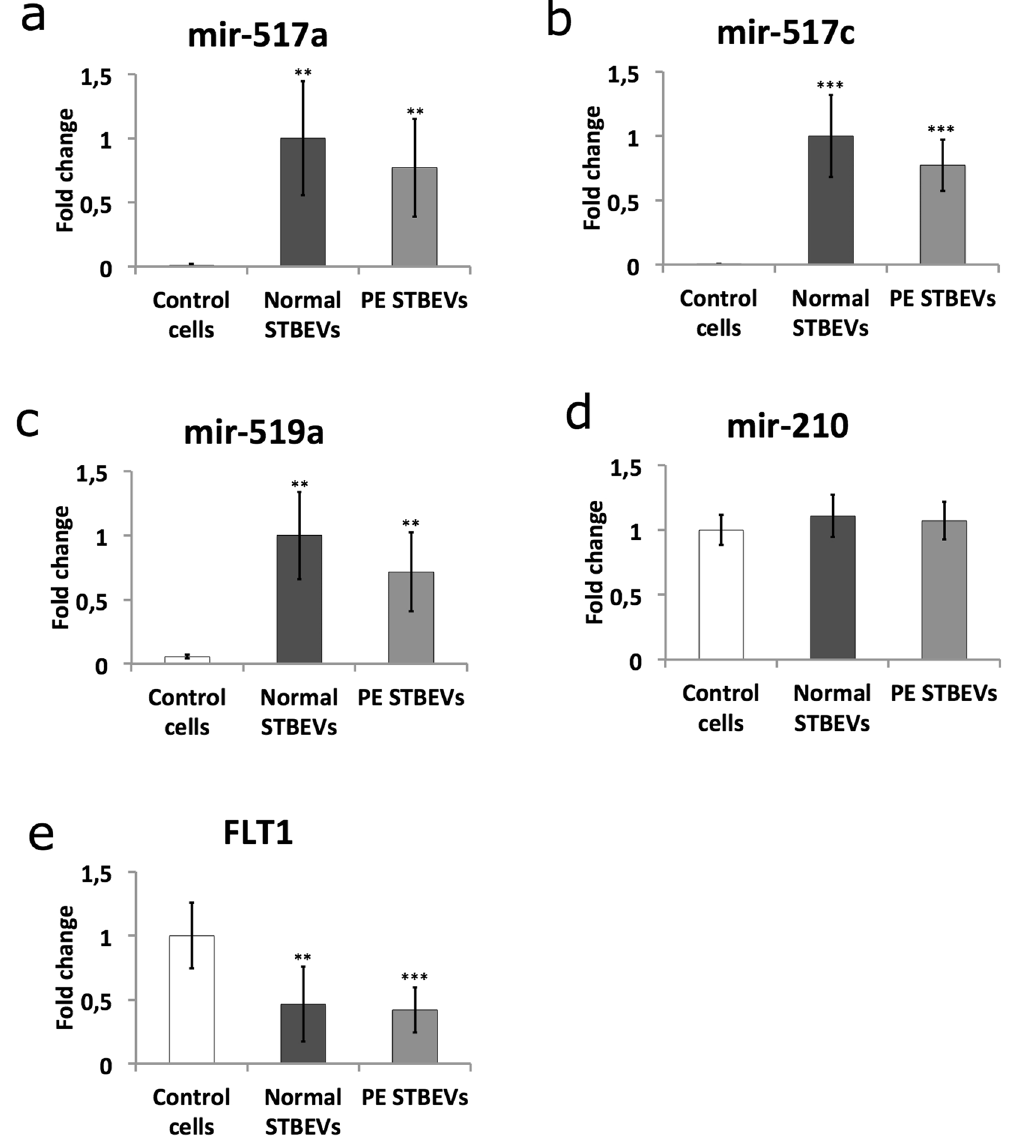
Figure 4. Micro-RNA and target gene expression in primary human coronary artery endothelial cells following STBEV treatment. The three placental C19MC miRNAs, mir-517a ( a ), mir-517c ( b ) and mir-519a ( c ), were analysed using RTqPCR. None of the three C19MC miRNAs were present in un-treated control cells. After treatment with normal (n = 5) or PE (n = 5) STBEVs, the levels of all three miRNAs increased significantly compared to control cells. No significant difference was seen in miRNA expression when comparing normal and PE STBEV treatments for any of the three C19MC miRNAs. The mir-210 ( d ) was present in controls cells and unaffected by STBEV treatment. The miRNA expression is expressed as fold change ( ± SD), which were calculated by normalizing against cells treated with normal STBEVs. Expression level of the predicted target gene FLT1 ( e ) was down regulated after normal (n = 5) and PE (n = 5) STBEV treatment. FLT1 is shown here as representative of the four genes; FLT1, TGFBR2, PDGFD and PDCD1LG2, all affected similarly by STBEV treatment. See also Fig. 5. The expression of predicted target genes was calculated as fold change ( ± SD) by normalizing against control samples, i.e. untreated control cells. Differences between control and normal STBEV treatments, as well as between control and PE STBEV groups, were analysed using Mann-Whitney U - test. * p < 0.05, ** p < 0.01, *** p <